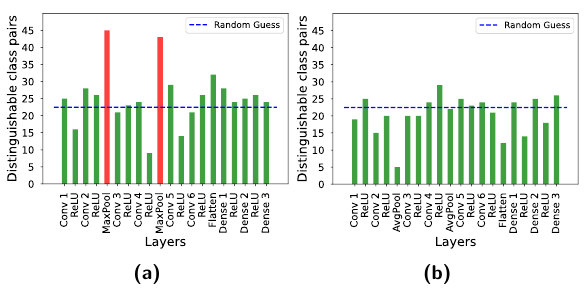
Figure 4: Number of distinguishable class pairs (out of 45) using timing side-channel of each layer in Custom CNN on CIFAR10 with (a) Max Pooling (b) Average